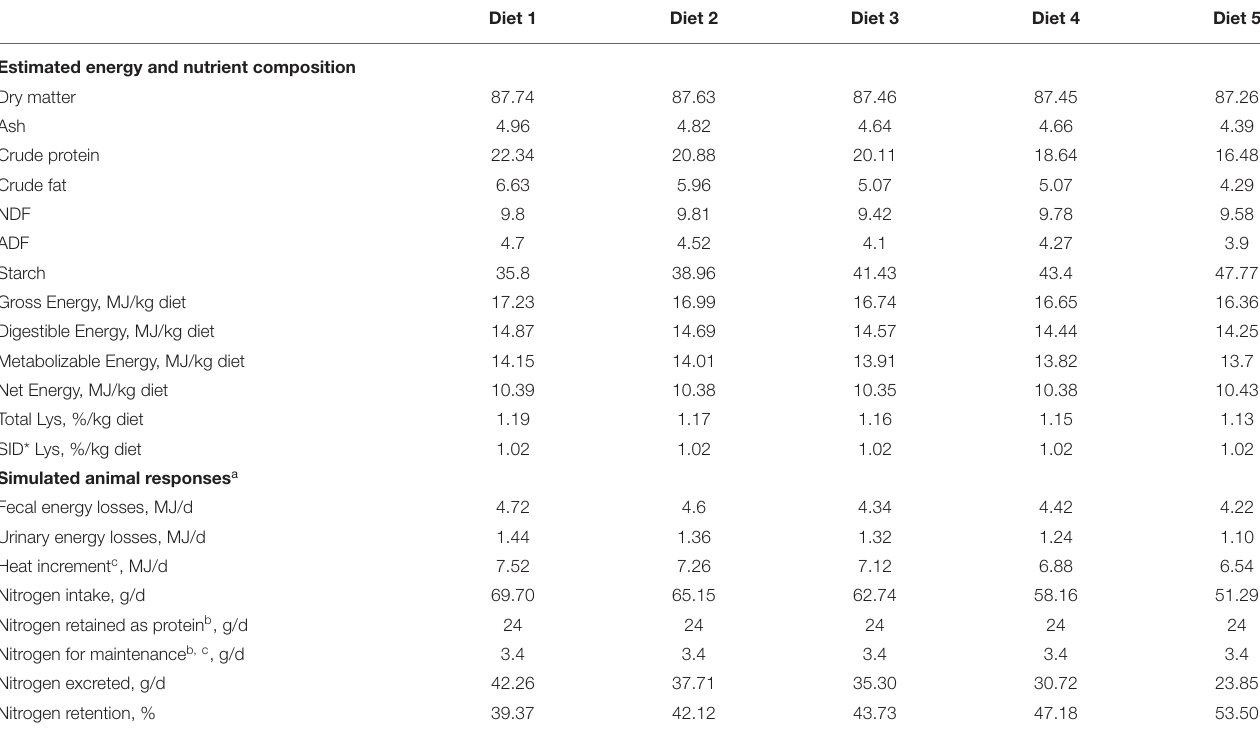
TABLE 1 | Estimated nutrient composition and simulated results of the diets formulated for grower pigs (25–50kg body weight) in standard Canadian diets when soybean and canola meals are gradually replaced by corn and feed-grade amino acids. Diet 1 Diet 2 Diet 3 Diet 4 Diet 5 Estimated energy and nutrient composition